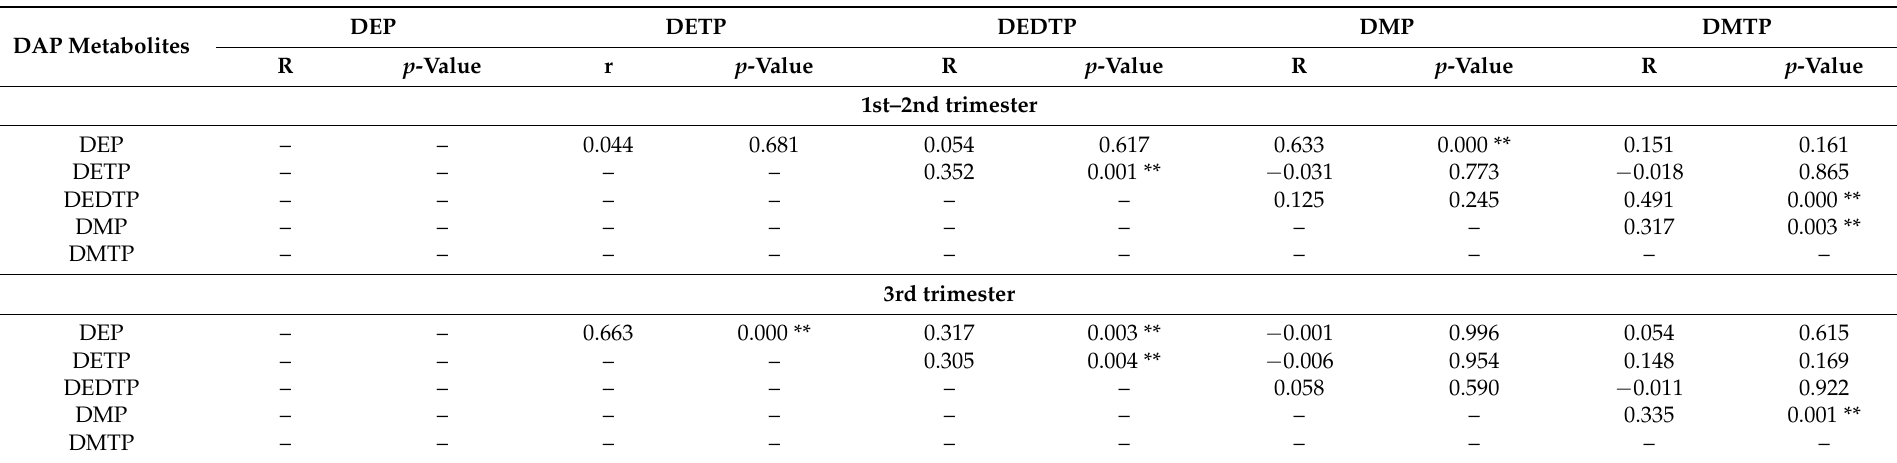
Table 3. Pearson correlation coefficient of DAP